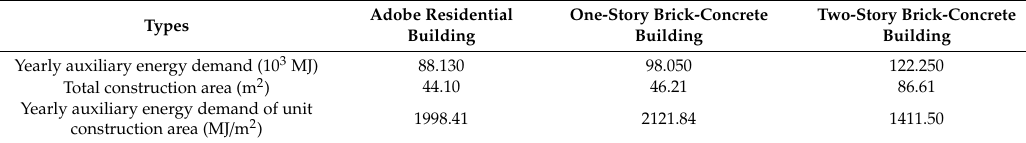
Table 19. Yearly auxiliary energy demand in unit construction area (MJ / m 2 ).